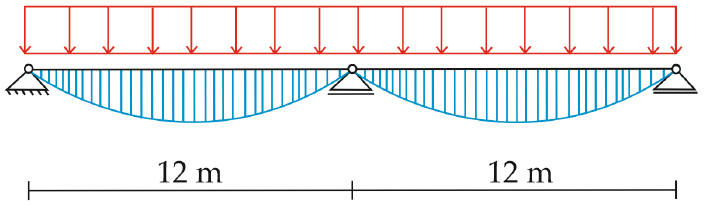
Figure 6. Structural slab system with acting loads and a corresponding bending moment diagram.